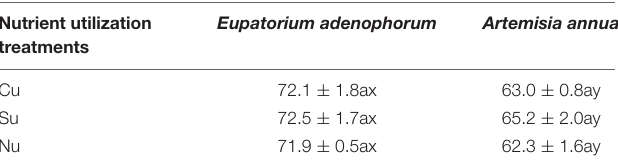
Nutrient utilization